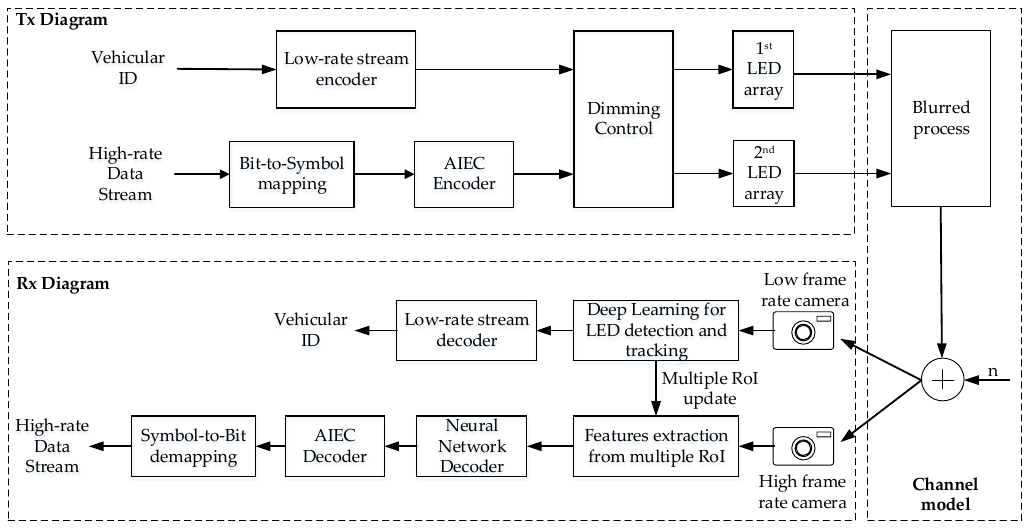
Figure 6. Proposed optical camera communication (OCC) system architecture using AI algorithms for RoI detection and decoding the DS8-PSK scheme from LED arrays.